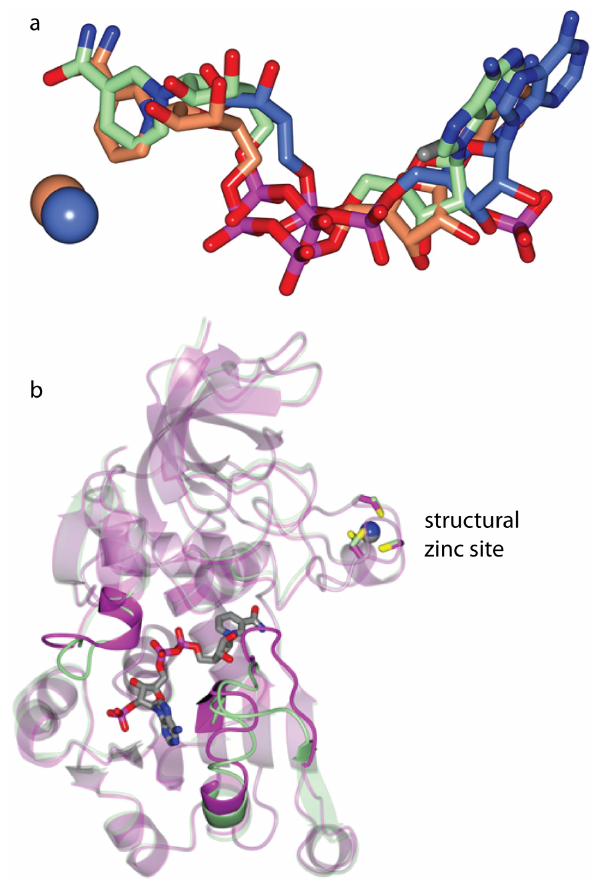
Figure 6. Active site view of ADH-NADPH (green) with YADH (coral, PDB 2HCY) and HADH (blue, PDB 5ADH) (a). YADH and HADH have adenosine-5-diphosphoribose and nicotinamide-8-iodo- adenine-dinucleotide bound in the active site respectively. Active site ligands are drawn as cylinders and active site Zn 2 + ions for YADH and HADH are represented as spheres. b) Superposition of ADH-WT (magenta) and ADH-NADPH (green). The NADPH molecule and Cys residues in the metal binding site are drawn as cylinders. The Zn 2 + ions associated with ADH-WT and ADH-NADPH are drawn as grey and blue spheres respectively. Regions with the largest conformational differ- ences are highlighted.